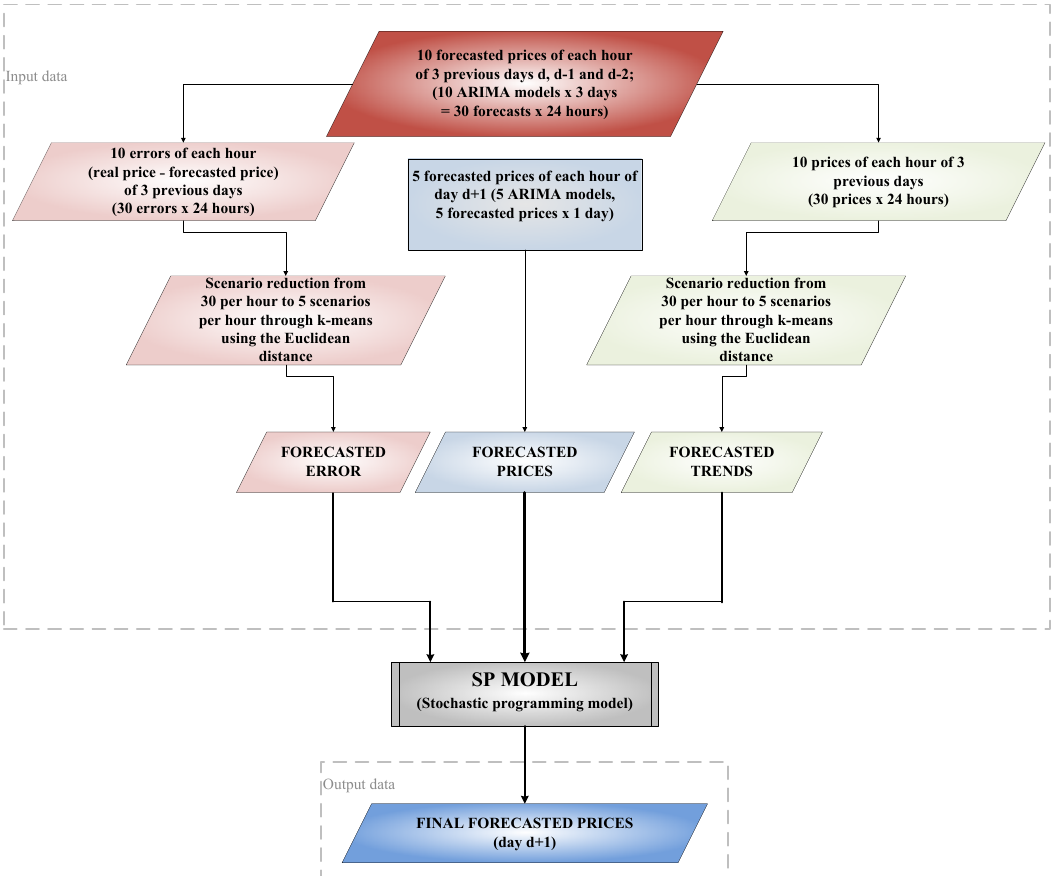
Figure 3. Diagram of the input data of the SP